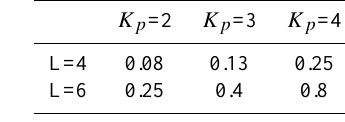
Table 2. (cid:127) V /(cid:127) cor (*1) from empirical